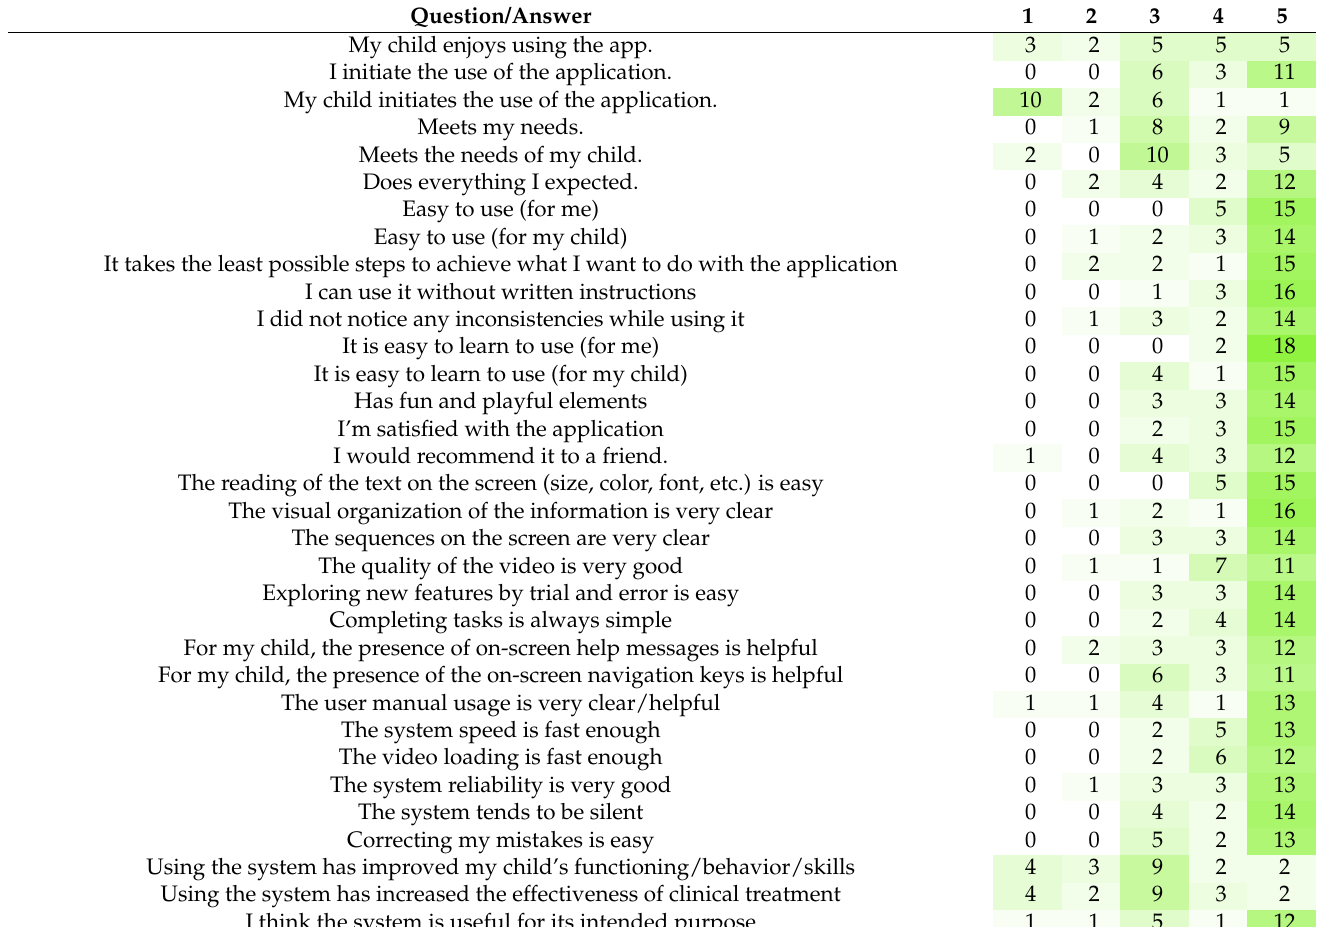
Table 2. Number of answers to the questions of application usefulness questionnaire (after application